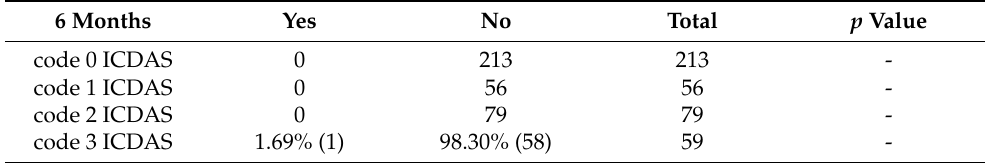
Table 6. Presence of carious lesions at 6 months.